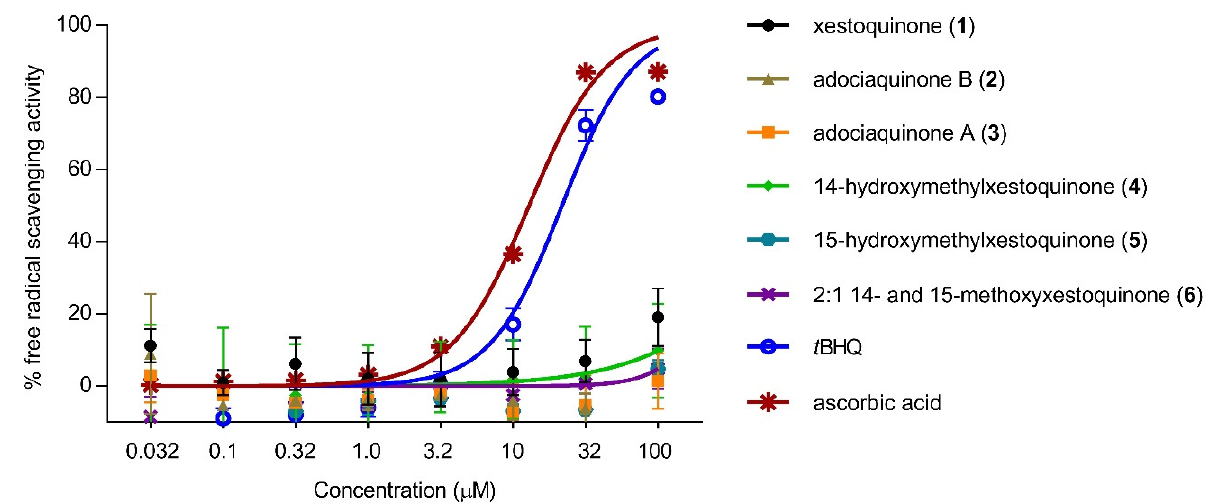
Figure 3. Direct antioxidant effects of xestoquinone and analogues ( 1 – 6 ). Xestoquinone and deriva- tives ( 1 – 6 ) did not show free-radical scavenging activity using the DPPH reagent. t BHQ and ascorbic acid served as positive controls and showed a concentration-dependent scavenging activity. Data are presented as mean ± SD, n = 3.